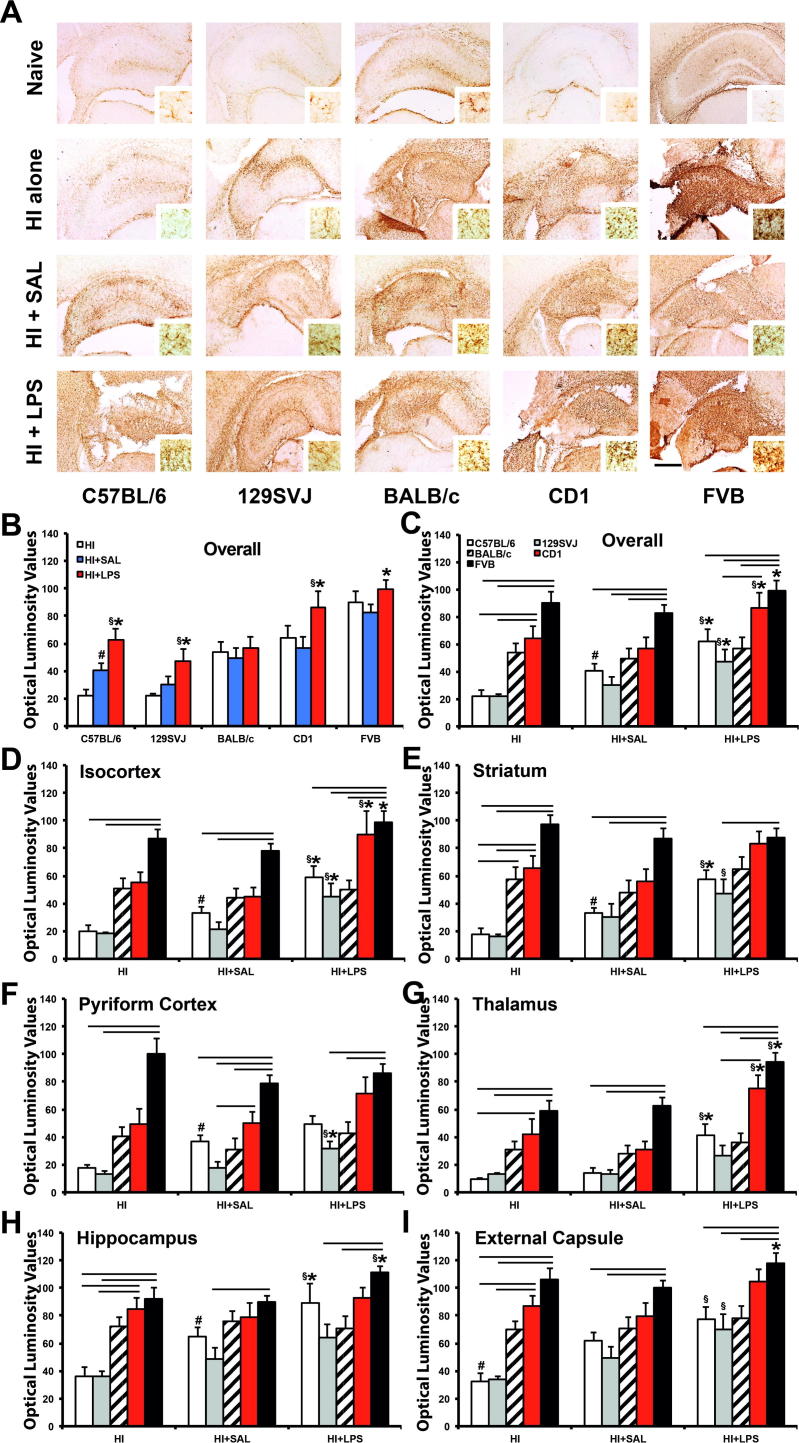
LPS-mediated sensitization to neonatal hypoxia–ischemia induces astrogliosis with increased GFAP-immunoreactivity (GFAP-IR) in the forebrain hemisphere on the side with carotid occlusion. (A) Hippocampal sections showing distribution of GFAP-IR in C57BL/6, 129SVJ, BALB/c, CD1 and FVB naïve animals (top row), only exposed to HI insult (second row), previously injected with saline (third row) or pre-exposed to LPS 12 prior to hypoxia–ischemia (last row). Note the clear increase in GFAP-IR the dorsoparietal isocortex, rostral hippocampus, striatum and external capsule in the saline pre-injected C57BL/6 animal (A). (B, C) Overall GFAP-IR per strain (B) and per treatment (C). (D–I) Quantification of astrogliosis using OPTIMAS-assessment of GFAP-IR with optical luminosity values (OLV) showed a significant, LPS-induced increase in the C57BL/6, 129SVJ, CD1 and FVB strains. C57BL/6 and FVB animals appeared most affected, overall (B, C) and with 4/6 regions showing a significant increase (D–I). This effect was also seen in 3/6 CD1 and 2/6 129SVJ brain regions, but not in the BALB/c strain. Interstrain comparison demonstrated a clear significant astroglial immunoreactivity for the FVB strain when compared to most strains in both HI + SAL and HI + LPS treatments, and particularly with C57BL/6 and 129SVJ in terms of HI alone injury. p < 0.05 for Kruskal–Wallis one-way analysis, followed by Dunn multiple comparison test (∗for HI + LPS vs. HI + SAL, §for HI + LPS vs. HI alone, #for HI + SAL vs. HI alone, overhead bar for interstrain treatment comparison). Bar scale = 0.5 mm.